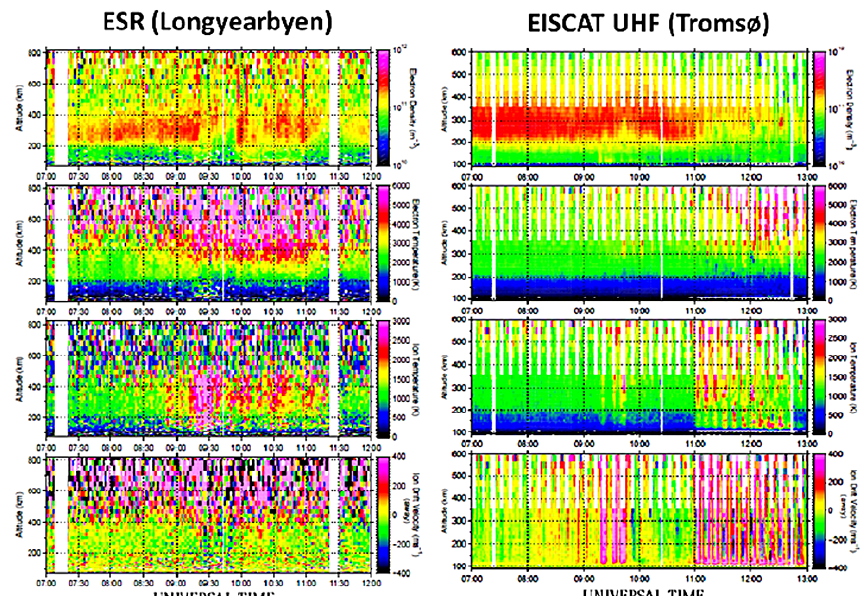
Figure 5. Ionospheric variations in the altitude range of 90–800km observed with the EISCAT Svalbard 42m radar (ESR) at Longyearbyen (left) and those in the altitude range of 90–600km observed with the EISCAT UHF radar at Tromsø (right) on 12 March. The electron density, electron temperature, ion temperature, and ion drift velocity are shown from the top to bottom, respectively, in each